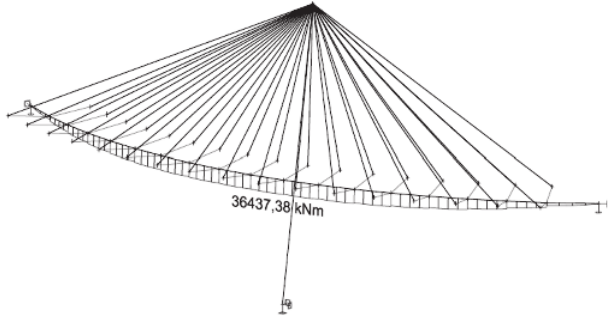
Figure 31 Bending moment on curved deck (P+L): bilateral case